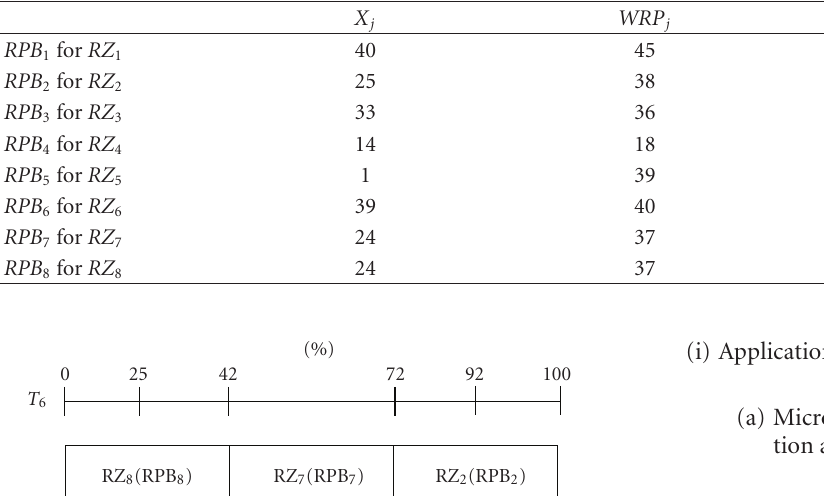
Table 4: Coordinates of obtained RPBs.